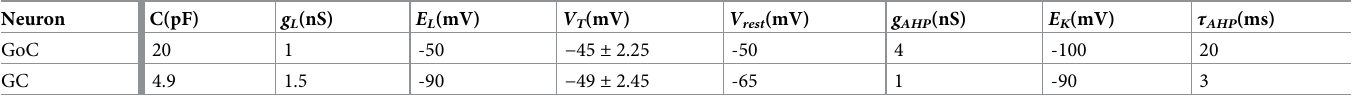
Table 1. The parameters of single cell